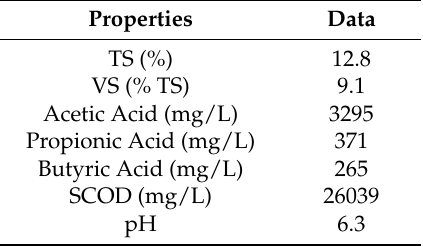
Table 2. The basic properties of acidification liquid in the acidogenic phase at 45 days.